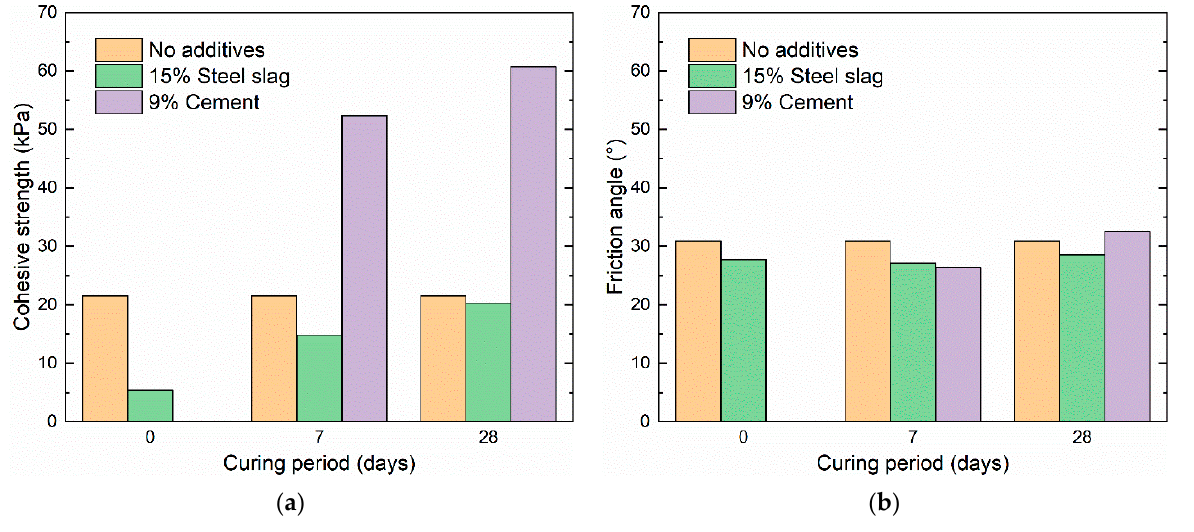
Figure 5. Cohesive strength and internal friction angle of red clay and cement/steel slag-modified specimens: ( a ) the cohesive strength of specimens; ( b ) internal friction angle of specimens.